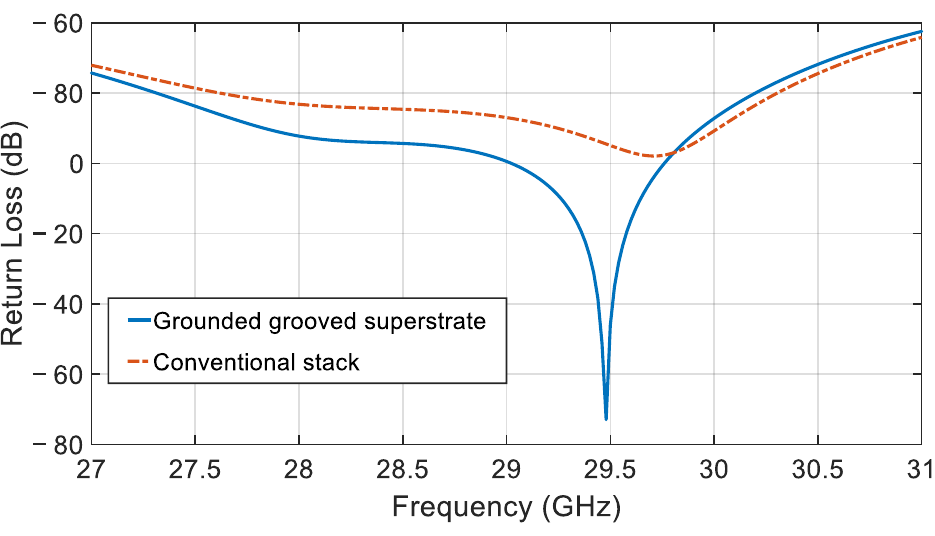
Figure 11. Feeding network schematic (ground plane hidden).